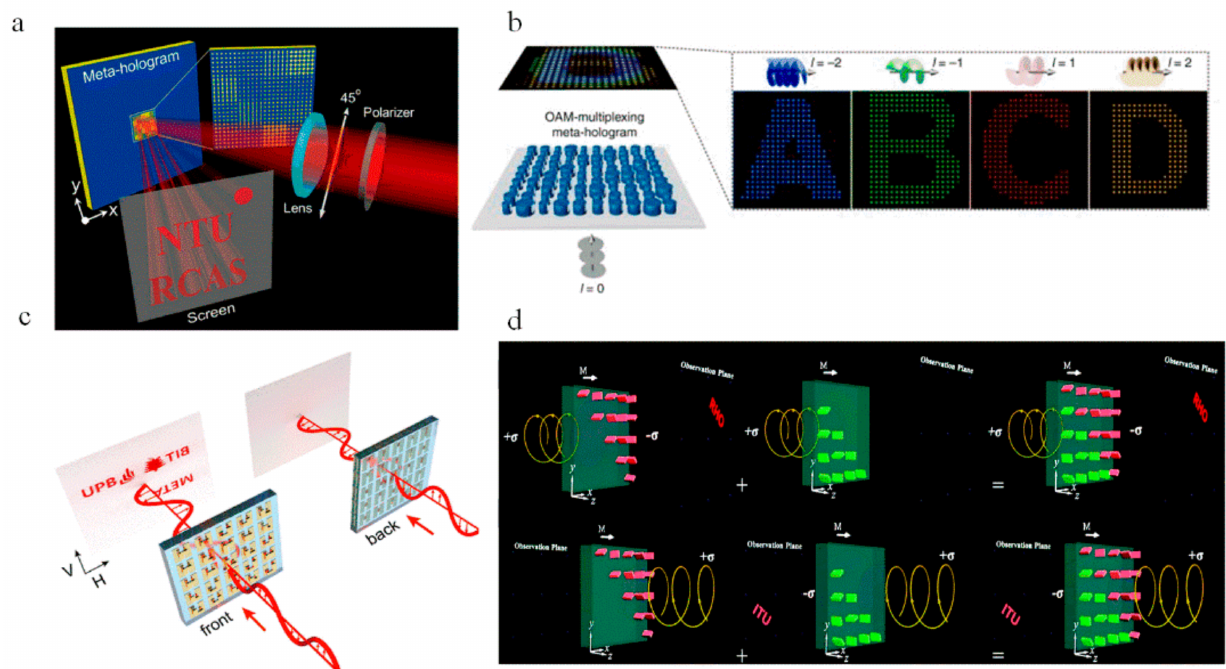
Figure 2. ( a ) Linear polarization multiplexing holography. Reprinted with permission from ref. [70]. Copyright 2014 American Chemical Society. ( b ) Schematic of an OAM-multiplexing meta-hologram capable of reconstructing multiple distinctive OAM-dependent holographic images. Adapted with permission from ref. [80]. Copyright 2019 Springer Nature. ( c ) Illustration of a double-layer metasurface with asymmetric functionalities. Reprinted with permission from ref. [85]. Copyright 2019 American Chemical Society. ( d ) The generation of direction-multiplexed metasurface holograms. Reprinted with permission from ref. [86]. Copyright 2019 Royal Society of